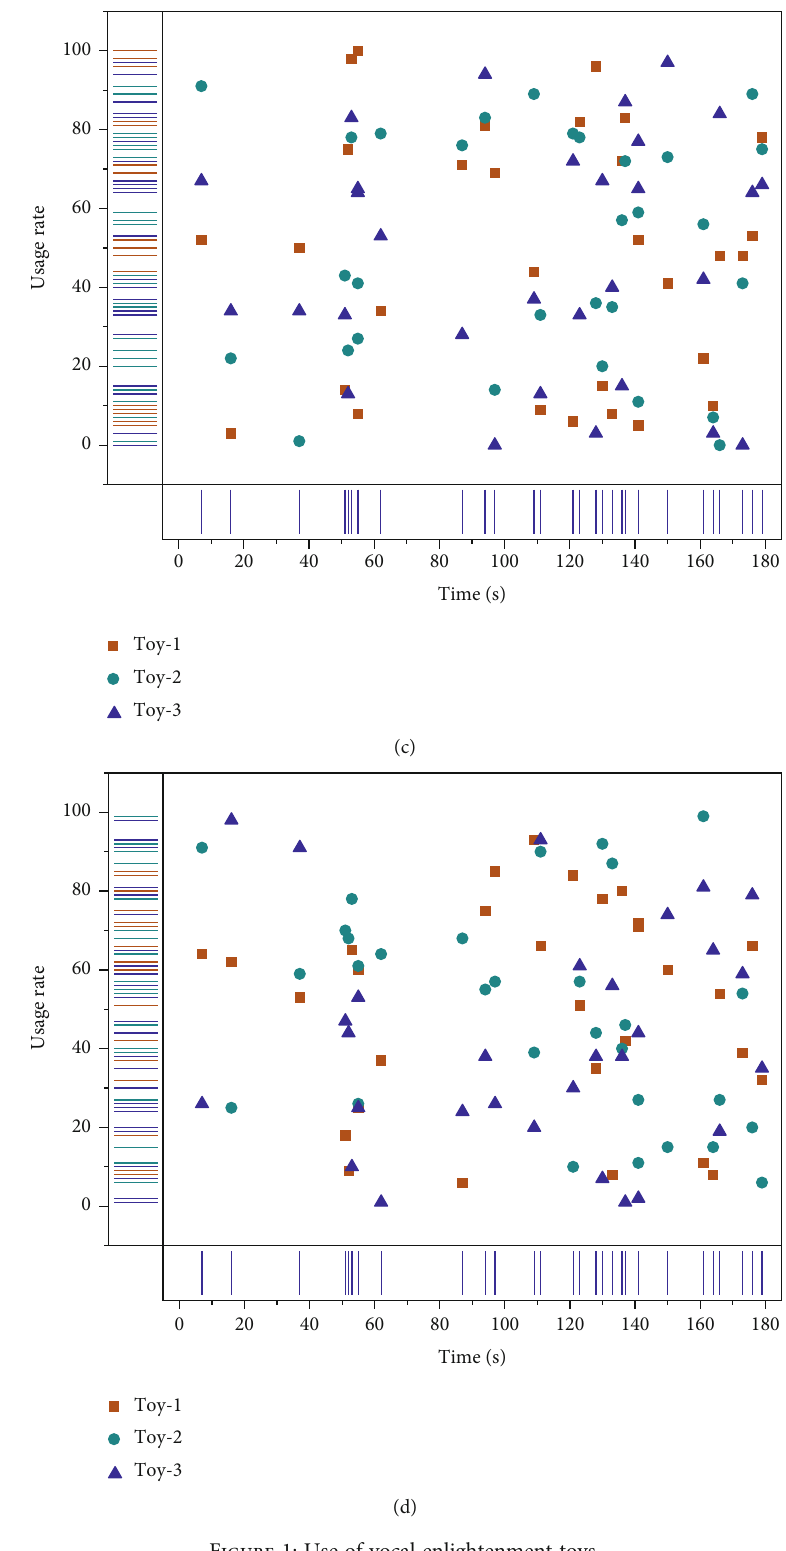
Figure 1: Use of vocal enlightenment